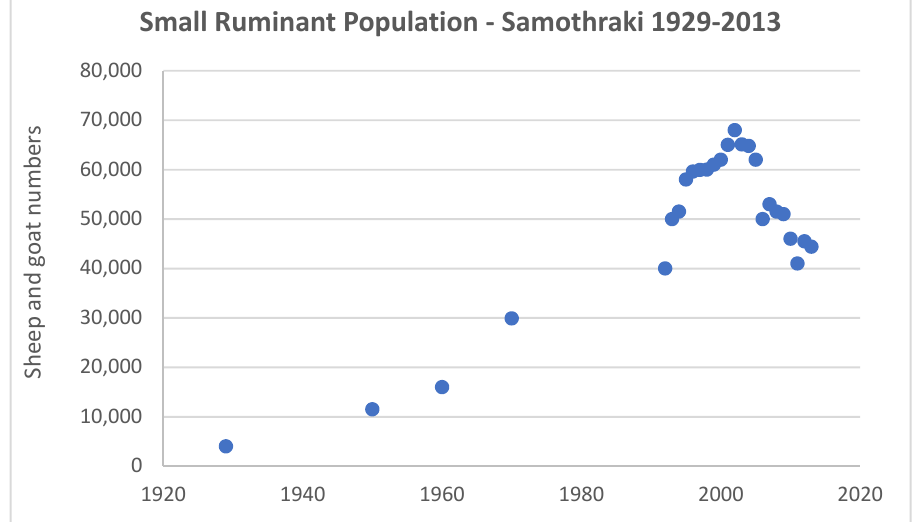
Figure 9. Development of small ruminant population on Samothraki (1929–2013); Source: EL-STAT.